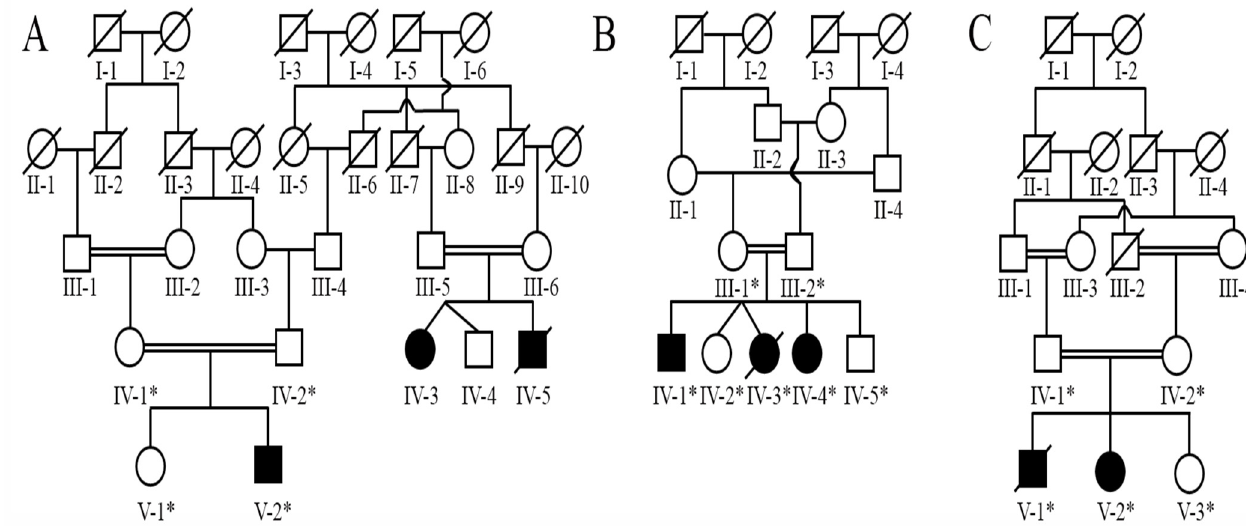
Figure 1. Pedigrees of Families ( A – C ) segregating Dystrophic epidermolysis bullosa in autosomal recessive manner. Double lines represent consanguineal union. Squares and circles indicate male and female members, respectively. Clear symbols indicate unaffected members, whereas filled symbols indicate affected members. An asterisk indicates that samples were accessible for the studies.